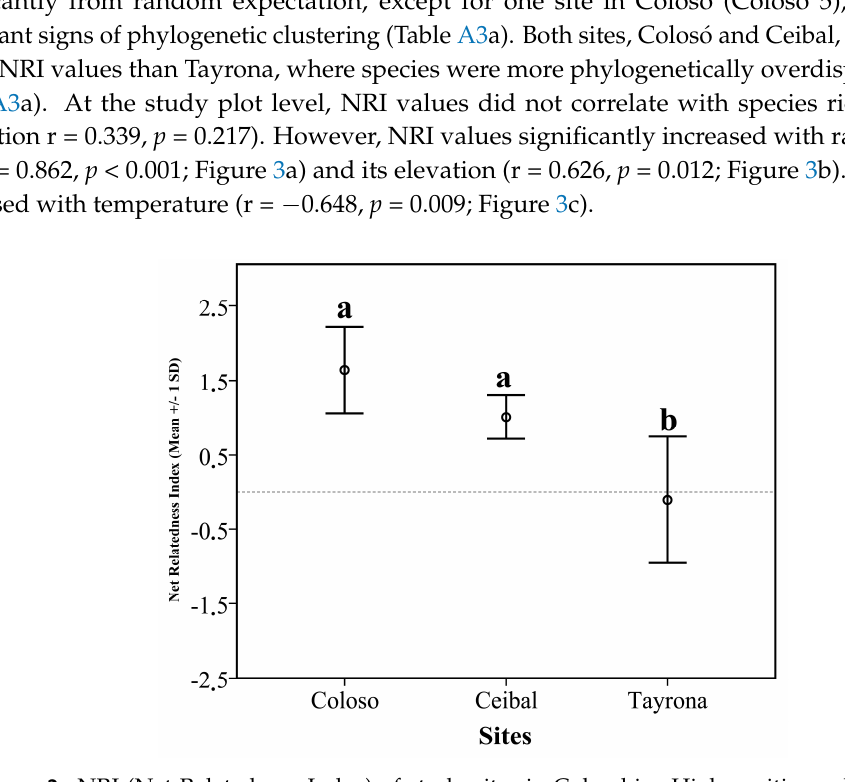
Figure 2. NRI (Net Relatedness Index) of study sites in Colombia. High positive values indicate phylogenetic clustering, while negative values indicate phylogenetic overdispersion. Shown are bars with mean (+/− 1 SD). Different letters indicate significant differences (ANOVA: F 2, 12 = 15.75; and p = 0.011, p < 0.001 respectively, Tukey p < 0.001, Table A3a)